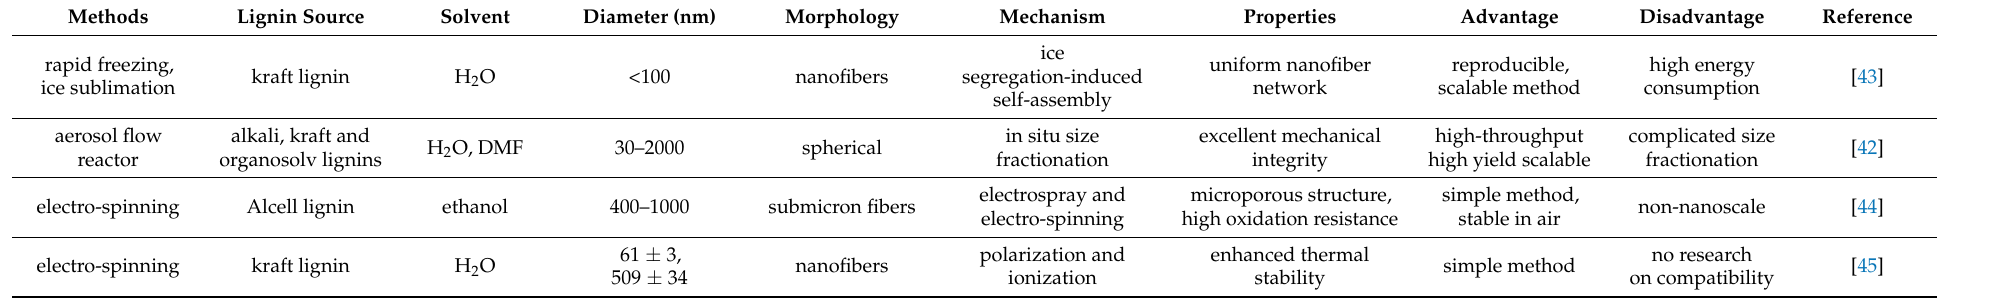
Table 5. Other Preparation of Lignin Nanoparticles.